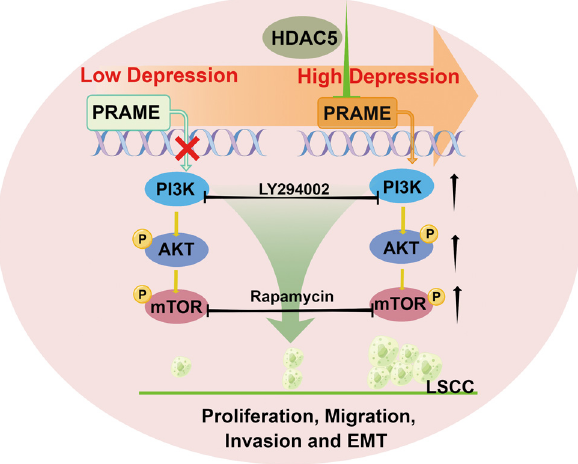
Figure 7: Schematic diagram summarizing the function of PRAME and PRAME - induced PI3K/AKT/mTOR signaling